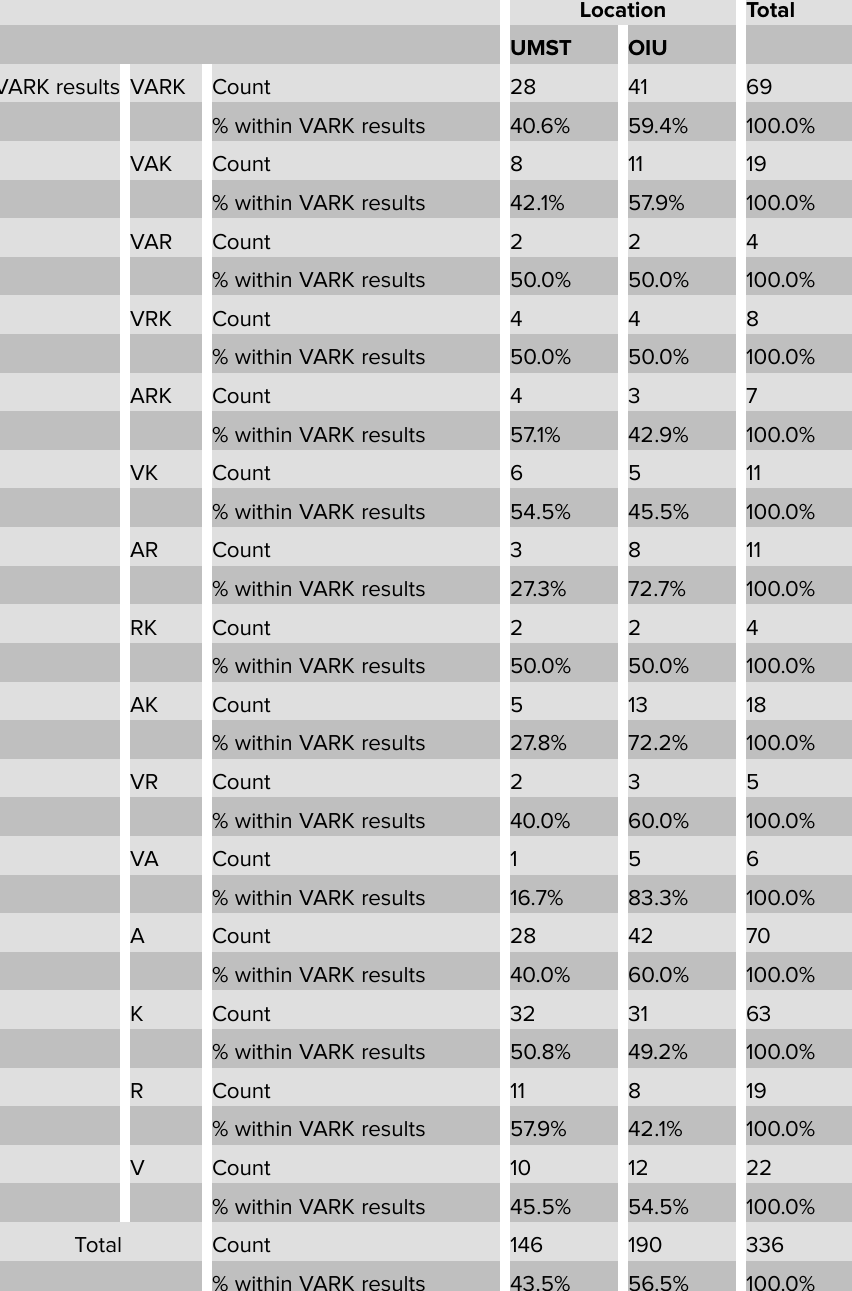
Table 4: VARK results among students of OIU and